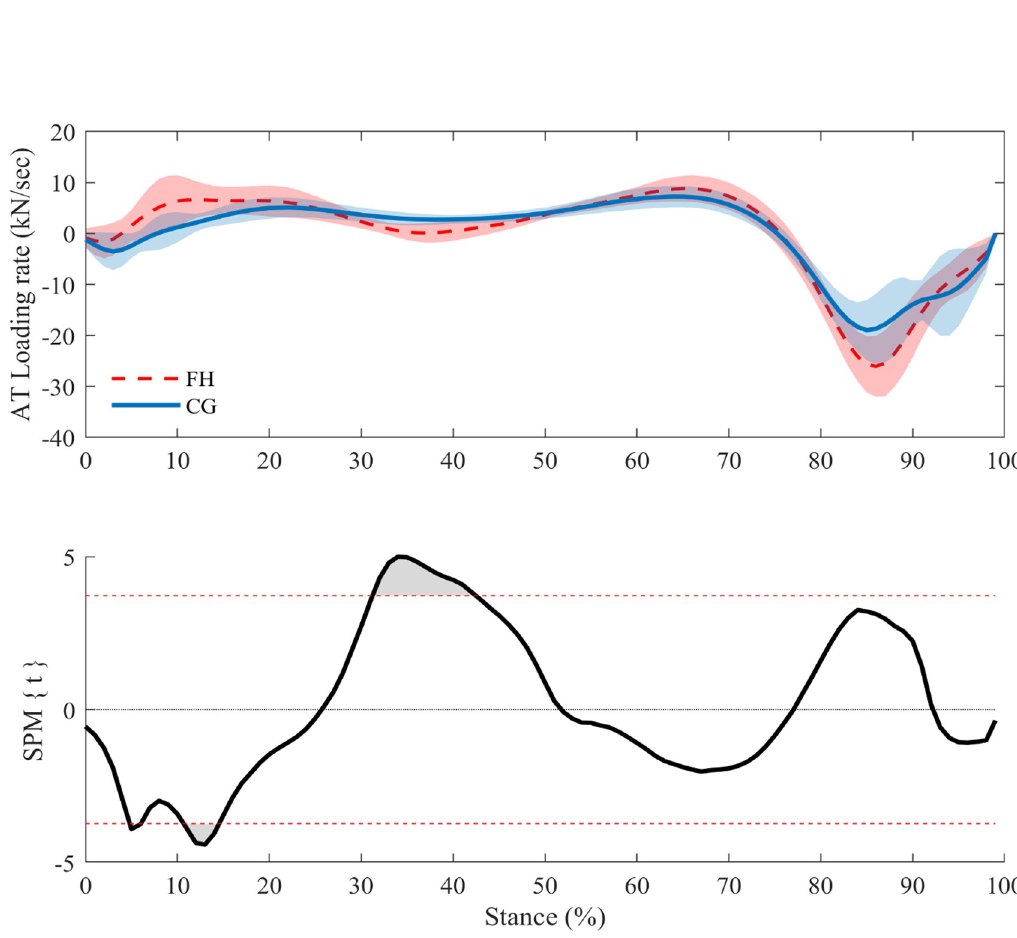
Fig 3. AT loading rate mean and standard deviation (top) and SPM analyses (bottom). t � = 3.72 indicates a significant difference in loading rate at ~5%, ~10–15% and ~30–45% stance ( p < 0.05).